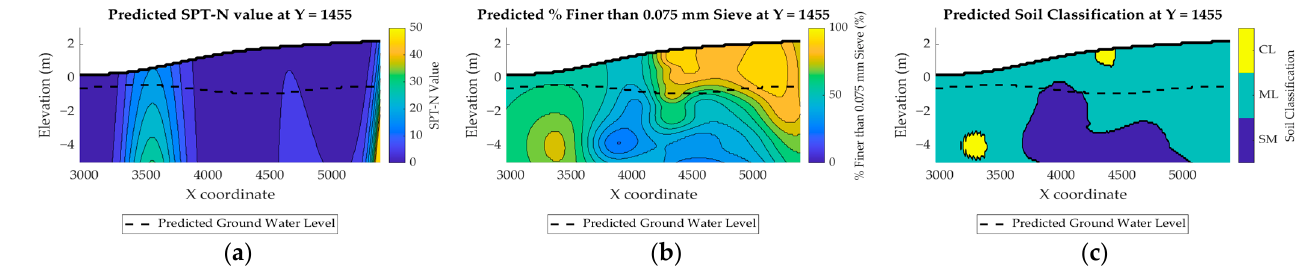
Figure 14. Cross-section view along X axis at Y coordinate = 1455 of predicted ( a ) SPT-N value, ( b ) percent fi ner than 0.075 mm sieve, ( c ) soil classi fi cation (X and Y coordinate; 1 unit = 1 m).